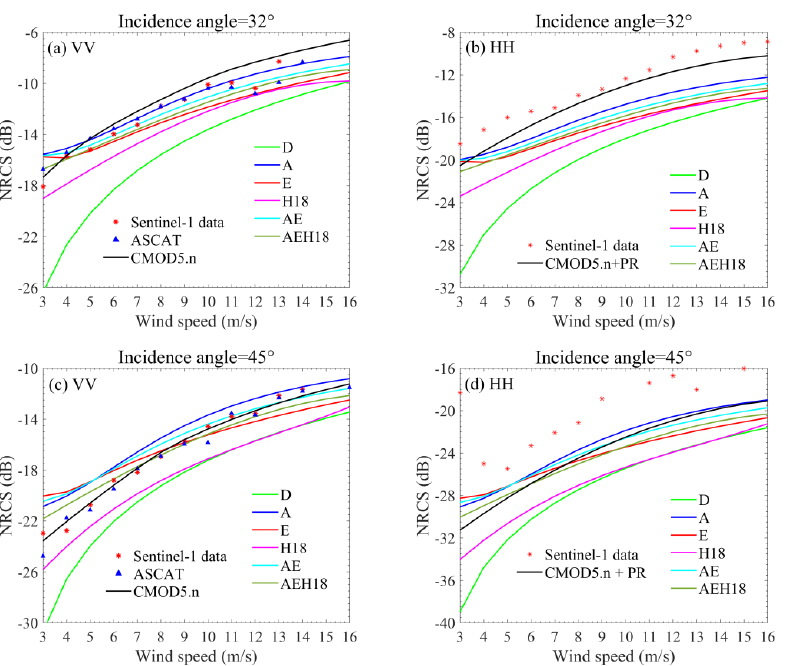
Figure 5. Predictions of the conventional TSM based on the four wind wave spectra and two com- posite spectra and their comparison with the Sentinel-1 data, ASCAT data, and empirical model as functions of the wind speed at the incidence angles of ( a , b ) 32° and ( c , d ) 45° in the upwind direction under VV and HH polarizations. Curves and symbols are the same as those in Figure 4. Figure 6 shows examples of probability density functions (pdfs) of scattering and scattering profiles predicted by the conventional TSM with the input of the six wave spec- tra, and their comparison with Sentinel-1 data, for the wind speed of 10 m/s and incidence angles of 32° and 45° in the upwind direction. Considering that the sea surface resolution affects the scattering distribution (a detailed analysis is presented in Section 4), we se- lected the Sentinel-1 data in the IW mode, which have the same facet size as the simula- tion, as the reference data. Furthermore, we excluded the Sentinel-1 data including swell based on the method in [43] to eliminate the influence of swell on the scattering. The scat- tering pdfs shown in Figure 6a,b were obtained from multiple images, and Figure 6c,d show the scattering profile of a single image. The ranges of the scattering distributions of the Sentinel-1 data are larger than those simulated by the conventional TSM based on the four individual wind wave spectra and two composite wind spectra (Figure 6a,b). Fur- thermore, the peak values of the pdfs for the Sentinel-1 NRCS are always smaller than those simulated with different inputs of wave spectra. The NRCS corresponding to the peak of the scattering pdf of the Sentinel-1 data is well predicted by the A spectrum at the wind speed of 10 m/s and incidence angle of 32° and is consistent with the two composite wind spectra at the wind speed of 10 m/s and incidence angle of 45° (Figure 6a,b). In Fig- ure 6c,d, we can see that the fluctuation range of the Sentinel-1 scattering intensity is in high agreement with the simulated results. Furthermore, the D spectrum obviously un- derestimates the NRCS of Sentinel-1 at the incidence angles of 32° and 45° when the wind speed is 10 m/s.